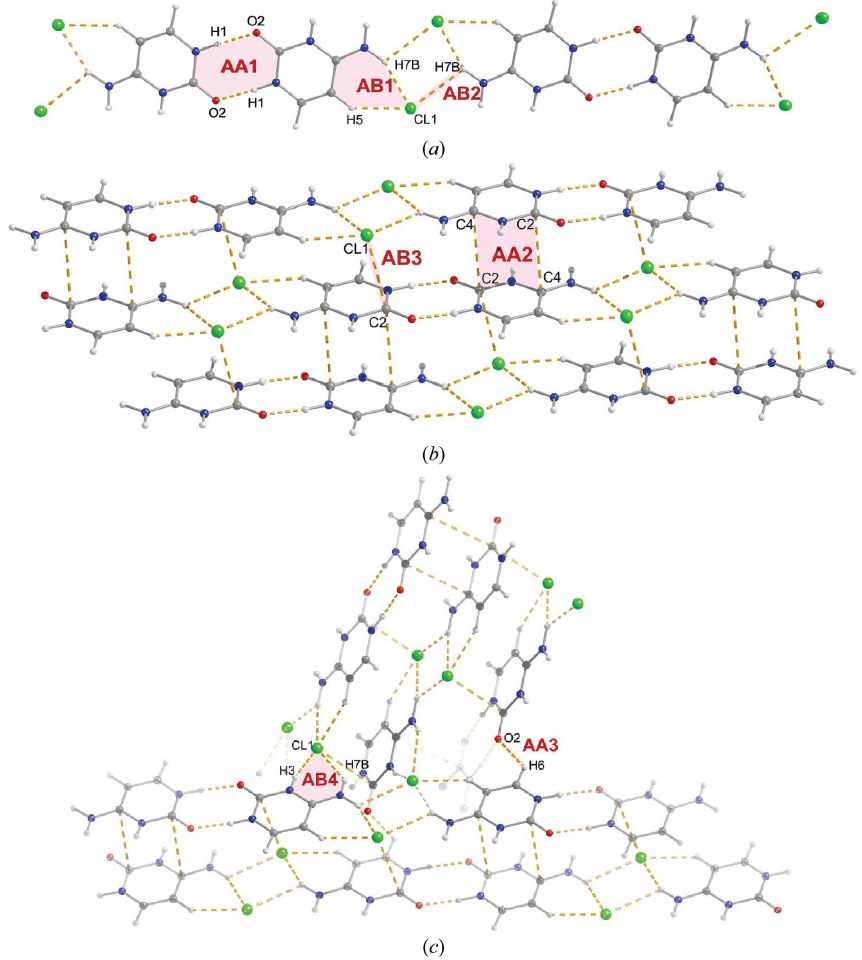
Figure 2 Dimeric motifs in the cytosinium chloride (CC)